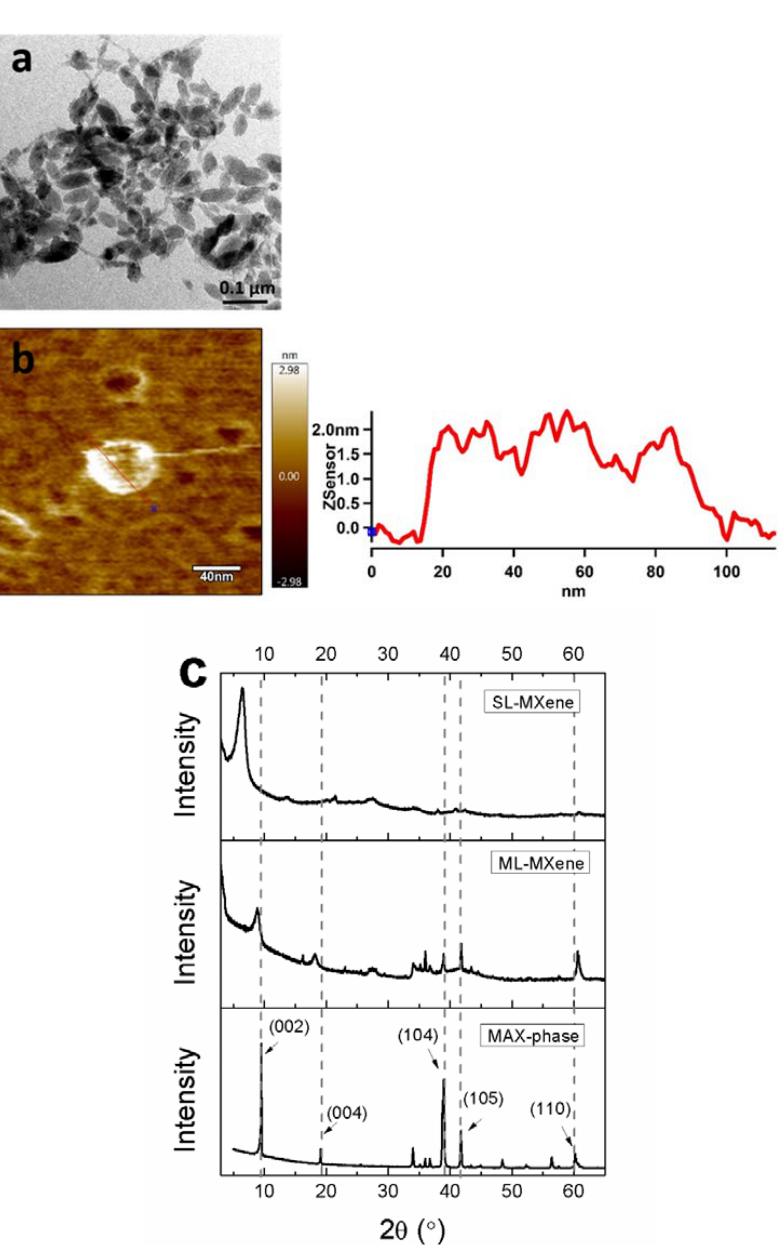
Figure 2. ( a ) transmission electron microscopy (TEM), ( b ) atomic force microscopy (AFM) of the Ti 3 C 2 T x nanosheets, and ( c ) X ‐ ray diffraction (XRD) of Ti 3 AlC 2 and ML and SL Ti 3 C 2 T x.